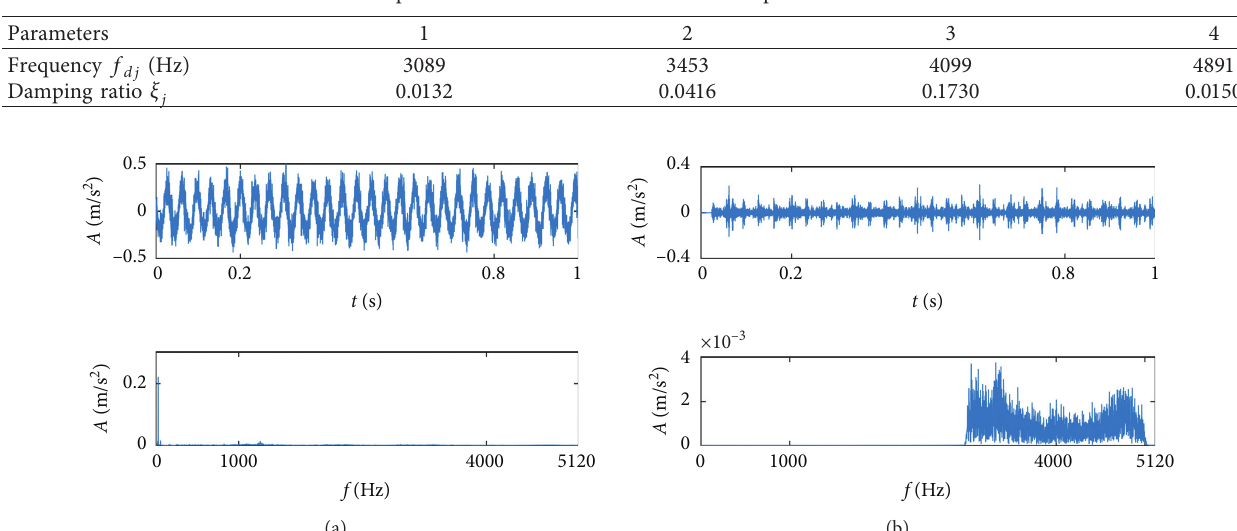
Figure 14: Experimental devices. (a) Tested engine. (b) Signal acquisition equipment. Table 2: The experimental results of multiorder model parameters’ identification.